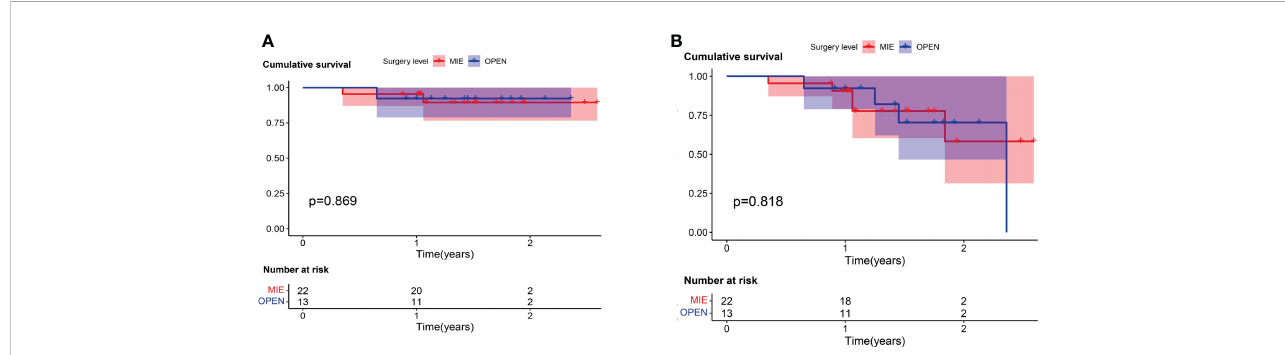
FIGURE 1 For patients who received camrelizumab plus chemotherapy, no signi fi cant difference was found in (A) overall survival (log rank = 0.027; P = 0.869) or (B) disease-free survival (log rank = 0.156; P = 0.693) between patients who underwent open surgery (Open) and those who underwent minimally invasive (MIE)